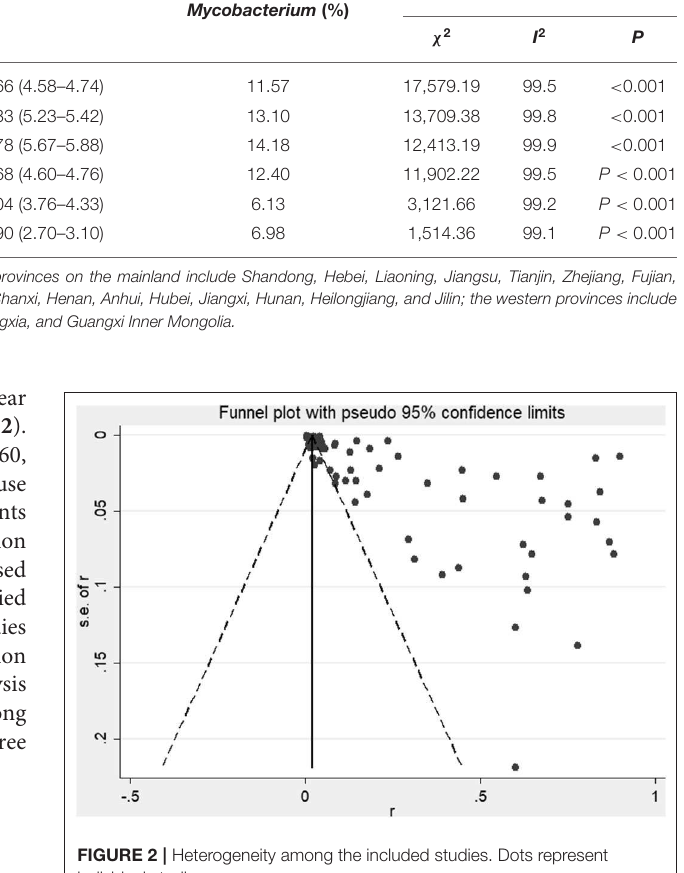
separation rate of NTM was higher in coastal areas than in inland areas, which showed a statistical geographic